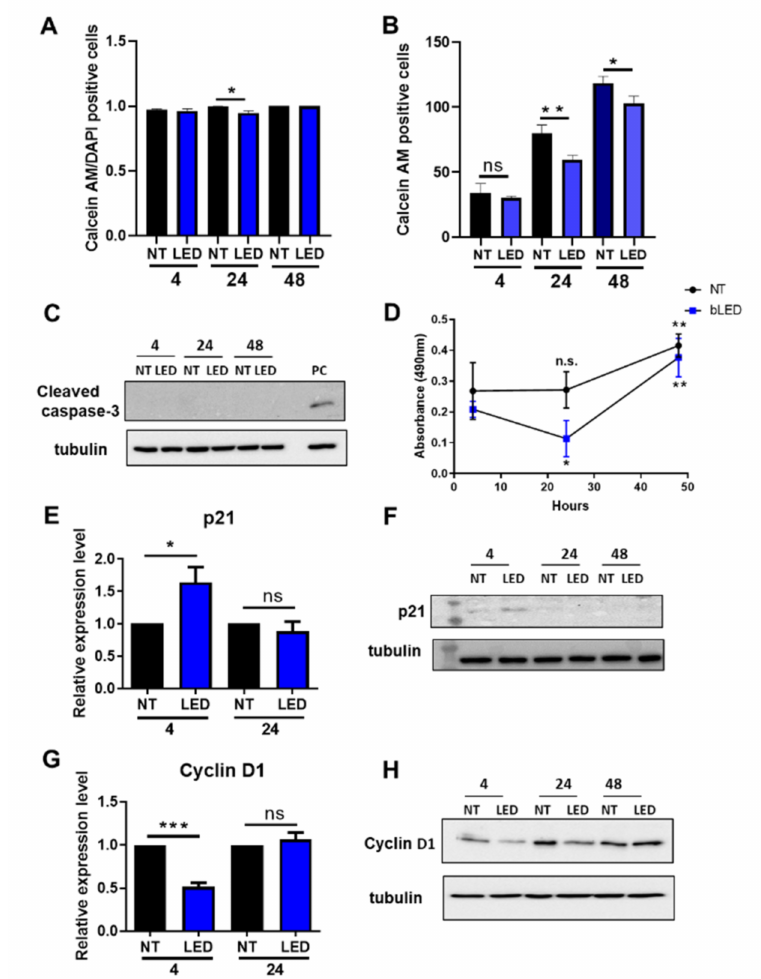
Figure 2. Exposure to b-LED causes a transient block in cell proliferation. ( A , B ) Cell viability test of HaCaT cells exposed to b-LED. HaCaT cells were pretreated with calcein AM (2 µ M) and exposed to b-LED for 4 h. Cells were then analyzed 4, 24 and 48 h after beginning of exposure to b-LED. Cells were fixed and stained with DAPI. Images were acquired by fluorescence microscopy. ( A ) Calcein AM/DAPI-positive cells; ( B ) calcein AM-positive cells. Bars represent the mean ± SEM from two independent experiments. Twelve fields containing at least 30 nuclei per field were analyzed. * p < 0.05; ** p < 0.01. ( C ) Western blot showing the expression of cleaved caspase 3 in HaCaT cells exposed to b-LED for 4 h. Cells were analyzed 4, 24 and 48 h after beginning of exposure to b-LED. Western blot analysis was performed on total lysates. Tubulin was detected as a loading control. Data are representative of three independent experiments. ( D ) Cell proliferation assay of HaCaT cells exposed to b-LED. HaCaT cells were left untreated or were exposed to b-LED for 4 h and were then evaluated for cell proliferation assays 4, 24 and 48 h after beginning of exposure to b-LED using a SpectraMax 13 microplate reader. The experiment was performed in triplicate and was repeated twice. * p < 0.05; ** p < 0.01; ns, not significant. ( E – H ) HaCaT cells exposed to b-LED for 4 h and then were analyzed 4 and 24 h after beginning of exposure. ( E ) Quantitative RT-PCR expression analysis of p21 in. ( F ) Western blot expression of p21 in HaCaT cells. ( G ) quantitative RT-PCR expression analysis of Cyclin D1 in HaCaT cells. ( H ) Western blot expression of Cyclin D1 in HaCaT cells. Quantitative RT-PCR was performed on total RNA. L34 mRNA levels were used for normalization. Results are expressed in terms of fold change; bars represent the mean ± SEM of duplicate determinations in four independent experiments. * p < 0.05; *** p < 0.001 and ns, not significant. Western blot analysis was performed on total lysates. Tubulin was detected as a loading control. Data are representative of three independent